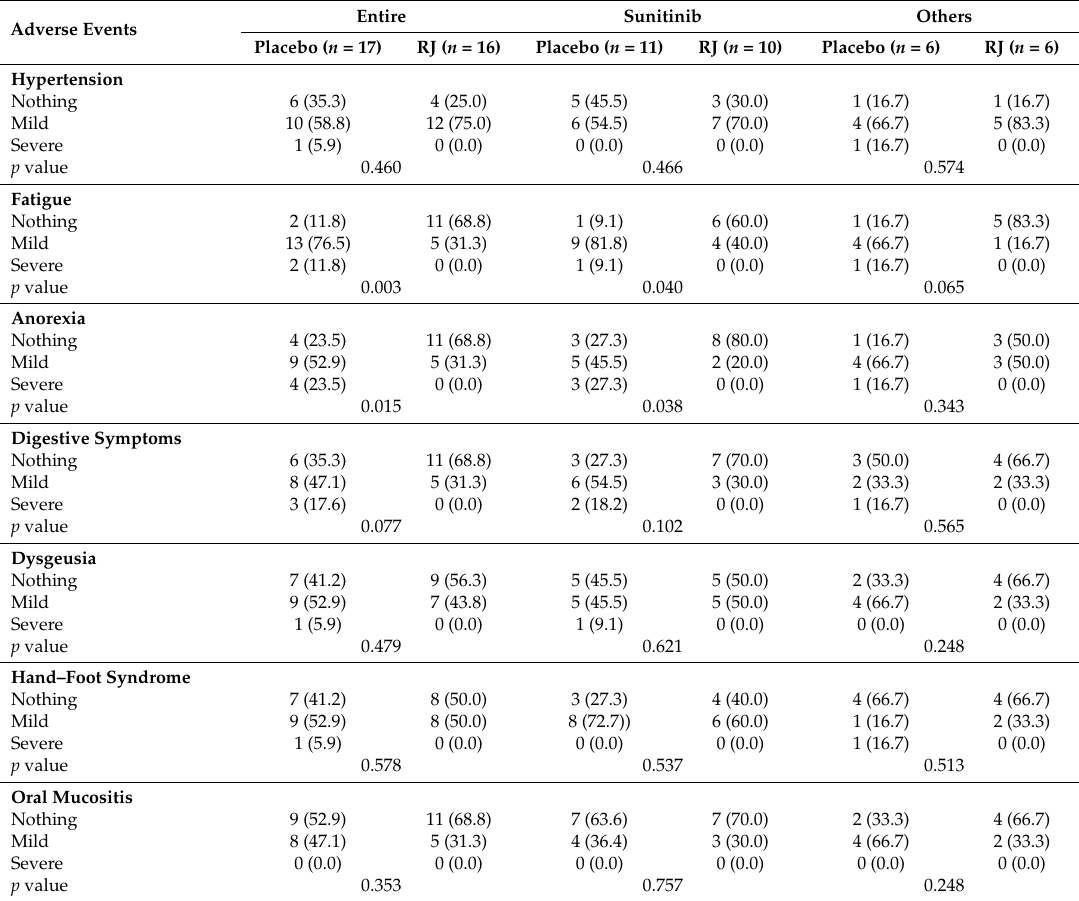
Table 3. Relationships between royal jelly intake and clinical